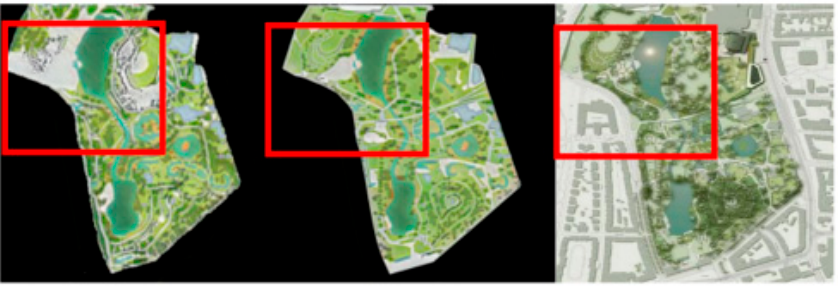
Figure 19. Test sample 5. Comparison of experimental results.